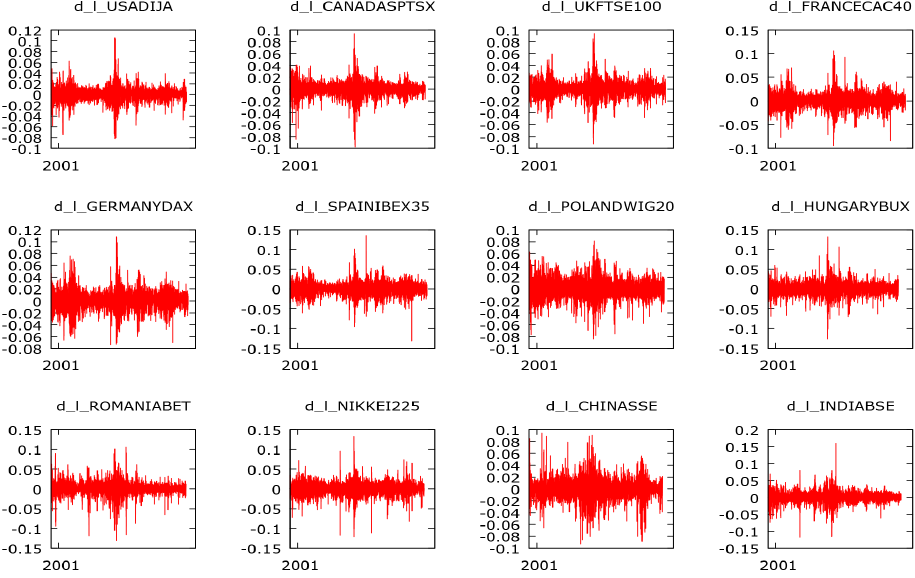
Figure 2. Volatility pattern of selected stock market indices (source: author’s own